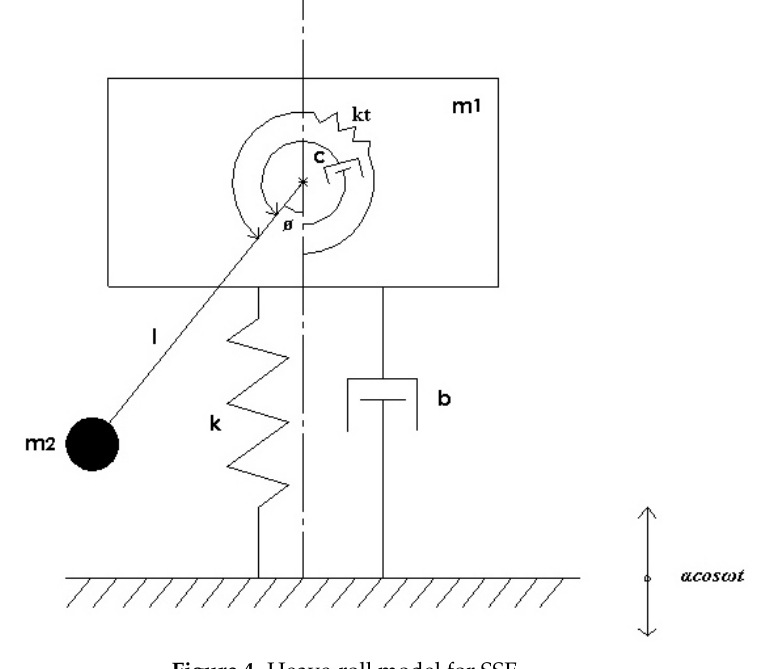
Figure 4. Heave-roll model for